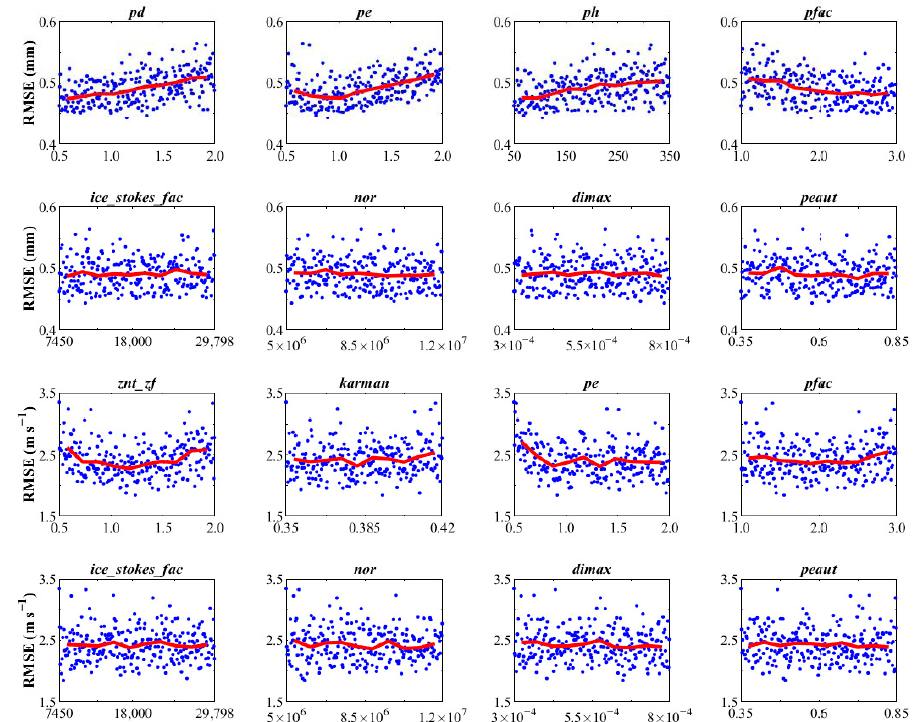
Figure 3. Comparisons of the responses of model performances to the sensitive parameters and the cloud microphysics parameters based on the 250 model simulations from sensitivity analysis experiment. Red curve represents an average of the simulation errors at each bin. The first and second lines are the response of precipitation simulation errors to precipitation sensitivity parameters and the microphysics parameters respectively. The responses of 10-m wind simulation errors to 10-m wind sensitivity parameters and the microphysics parameters are represented in the third and fourth lines respectively.